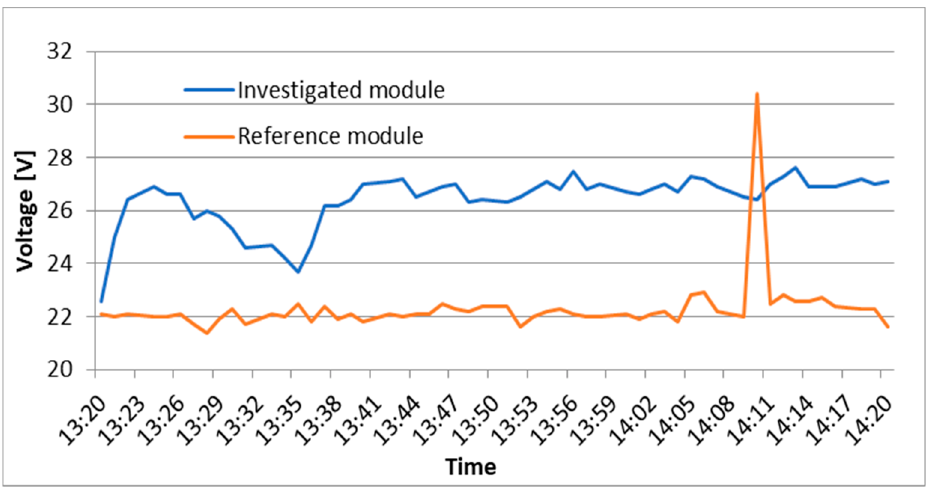
Figure 13. Voltages of investigated and reference modules during the maximal power test.